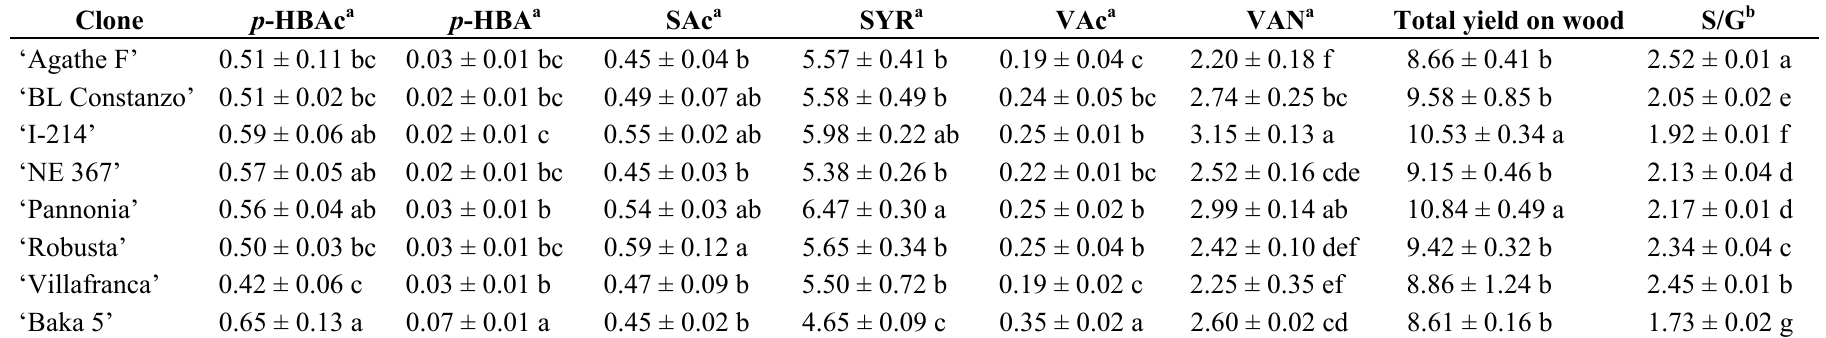
Table 6. The results of nitrobenzene oxidation (%) for the examined clones of Populus grown on the Gab č íkovo experimental site. Data represent means ±